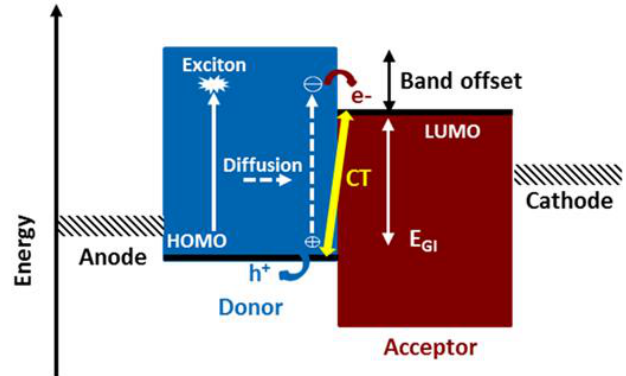
Figure 2. Basic geometry and energy level diagram of the BHJ